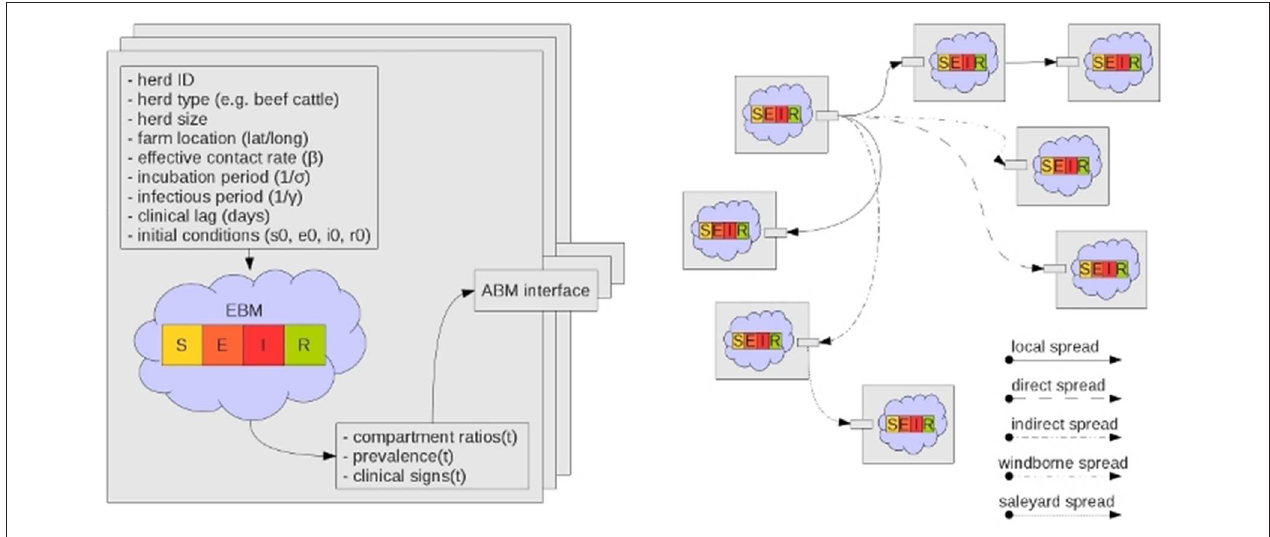
FIGURE 2 | Each herd instance has a customized SEIR ODE-based EBM. The ABM stochastically establishes infection connection paths between herds ( Bradhurst et al., 2013).